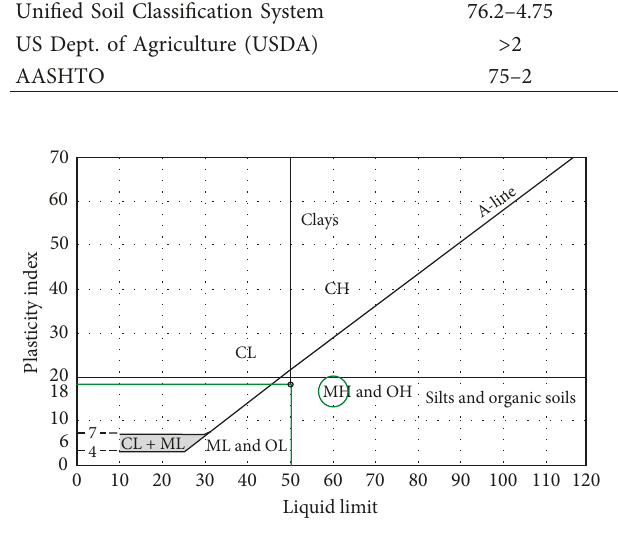
Figure 10: Liquid-plastic limit chart. Table 2: Grain-size distribution